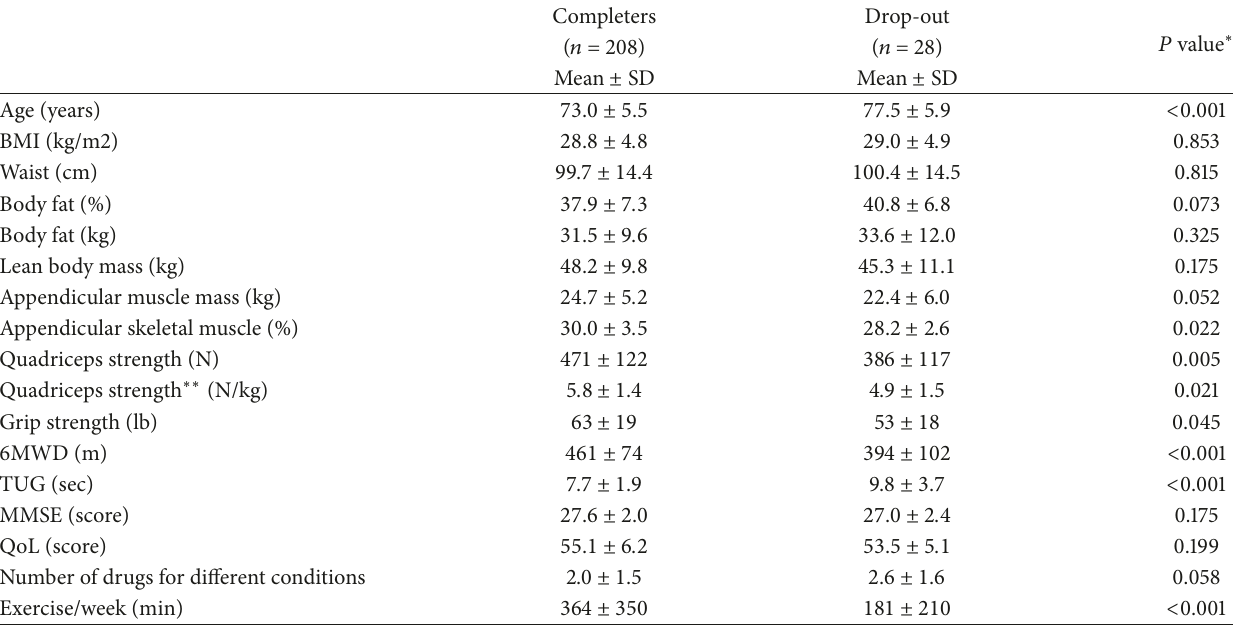
Table 2: Characteristics of participants that dropped out or completed the program.